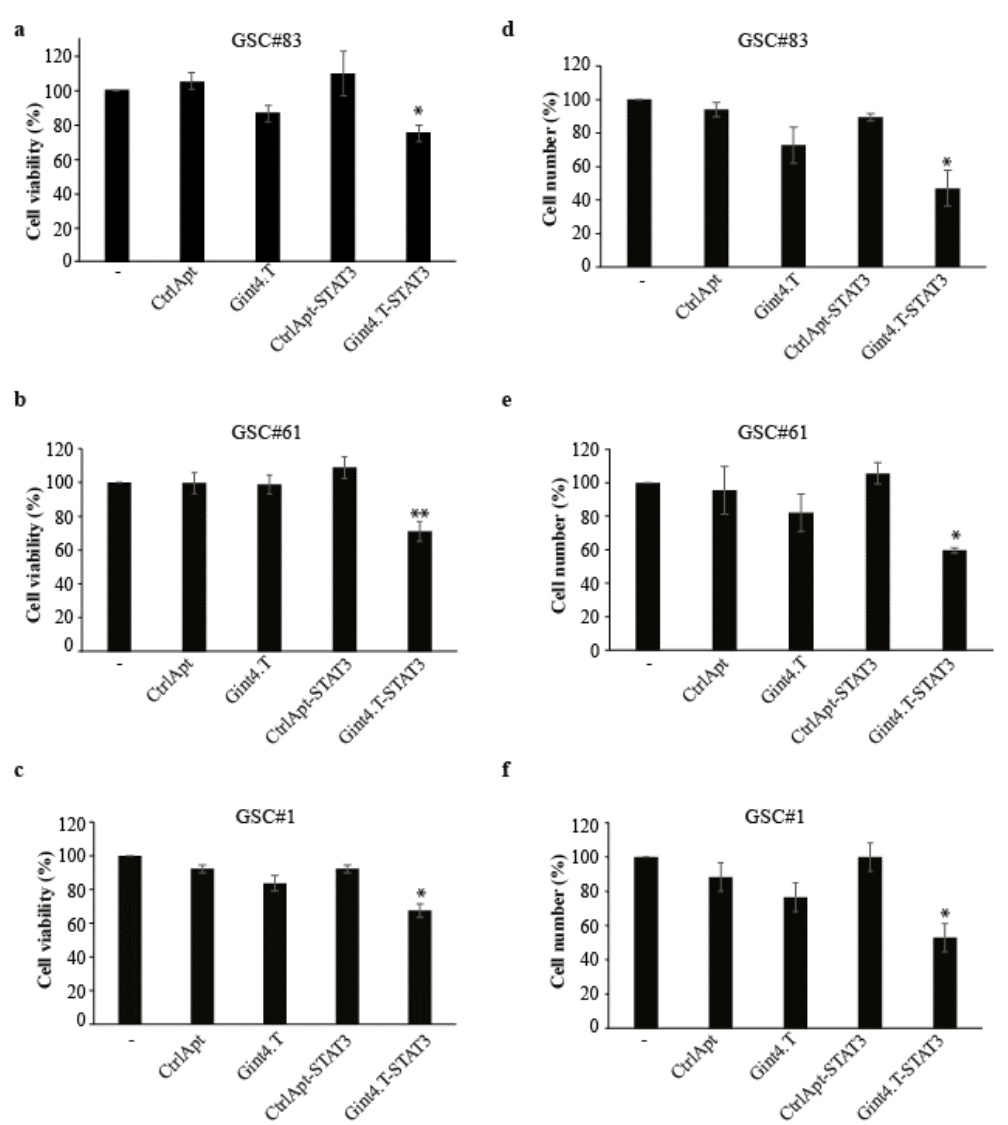
Figure 3. Gint4.T-STAT3 e ff ect on GSC growth. ( a – f ) Indicated GSCs (PDGFR β + ) were left untreated ( − ) or treated with indicated aptamer or conjugates (400 nmol / L) for 72 h. ( a – c ) Cell viability was measured and expressed as the percentage of the viable cells with respect to the untreated cells. ( d – f ) The cell number was counted and expressed as the percentage relative to the untreated cells. In ( a – f ), statistics were obtained by one-way ANOVA: *, p < 0.05; **, p < 0.01 (Gint4.T-STAT3 versus control sample). Vertical bars depict the mean ± SD ( n = 2).